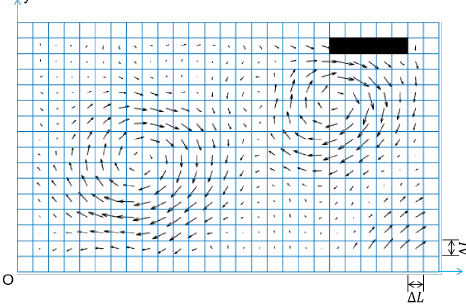
Figure 3. A grid map with ocean water surface features such as obstacles and ocean